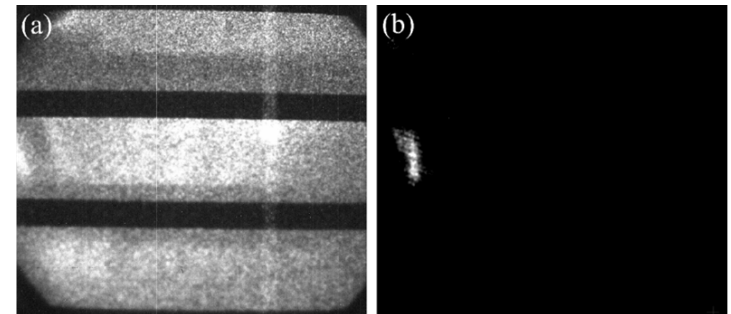
Figure 5. ( a ) Static image, while the PC receives a static DC bias of − 3 kV and the MCP receives a static DC bias of − 700 V. ( b ) Gating image with time dilation, when a − 3 kV DC bias and a driving pulse are applied to the PC, and an ultrashort pulse and a − 500 V DC bias are applied to the MCP.